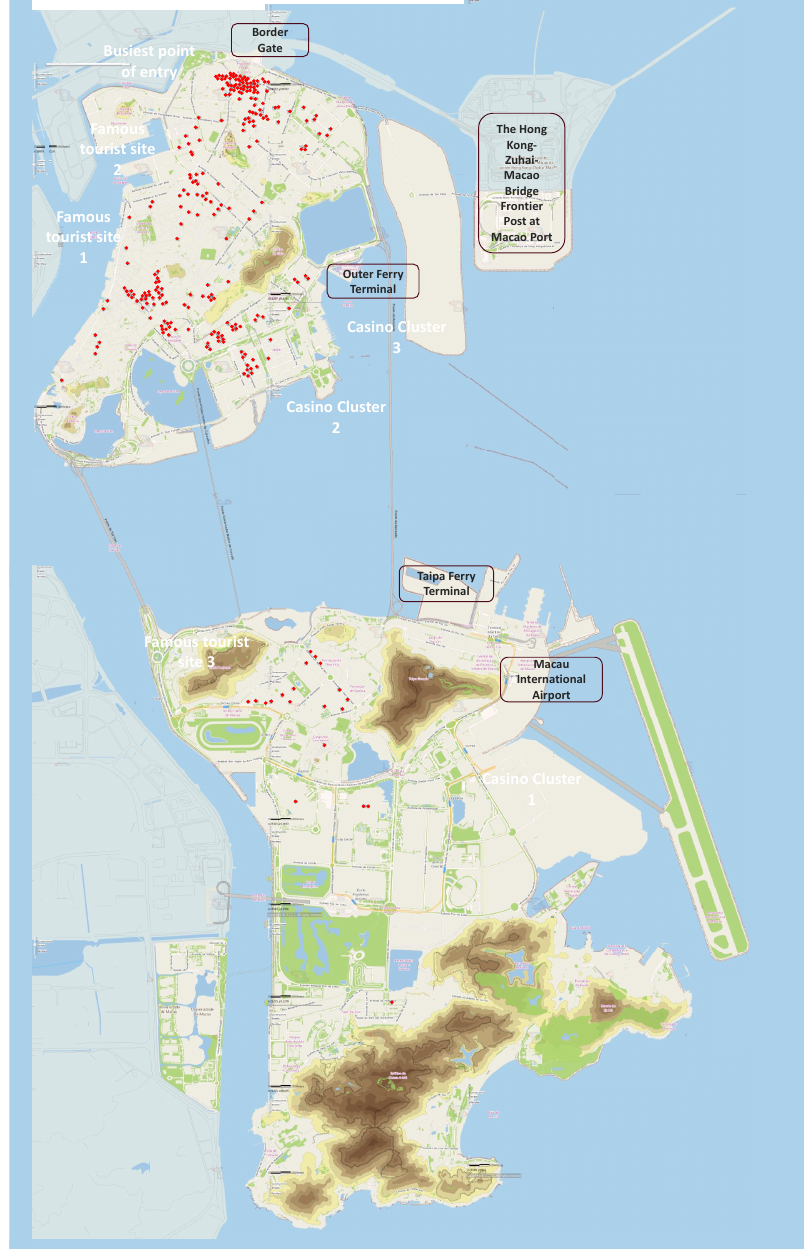
Figure 2. Distribution of community pharmacies in Macao. Map key (Map source, [27] Macao Cartography and Cadastre Bureau, 2020); casino cluster 1—includes Lisboa, Grand Lisboa, MGM, Wynn, Starworld, and L’Arc casino properties; casino cluster 2—the Cotai Strip, which includes Galaxy, Venetian Resort, Sands Cotai Central, Parisian, Studio City, City of Dreams, MGM, Cotai, Wynn Palace, and Grand Lisboa Palace integrated resort properties; casino cluster 3—includes Sands, Waldo, Rio, Landmark, Babylon, and Oceanus casinos; Border Gate—20.9 million visitors walked across in 2019 (Macao Government Statistics and Census Service, 2020); famous tourist